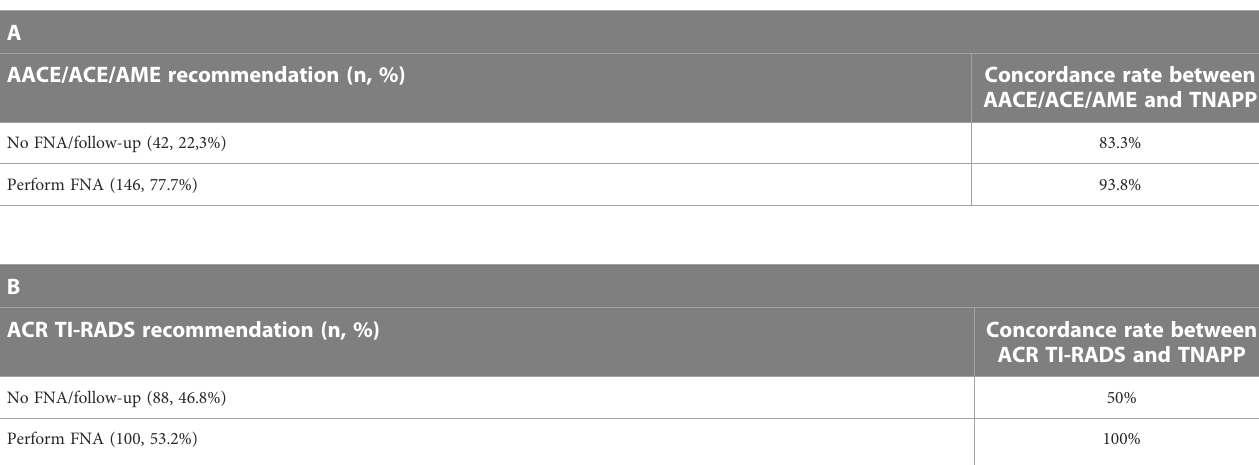
TABLE 4 Concordance rates between the AACE/ACE/AME and TNAPP (A) and ACR TI-RADS and TNAPP (B) to recommend FNA or follow-up (n = 188).